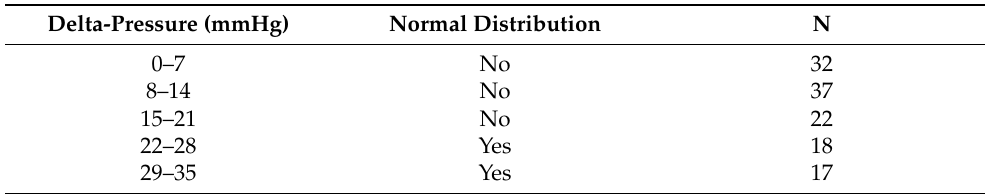
Table 2. Significance results between groups of Table